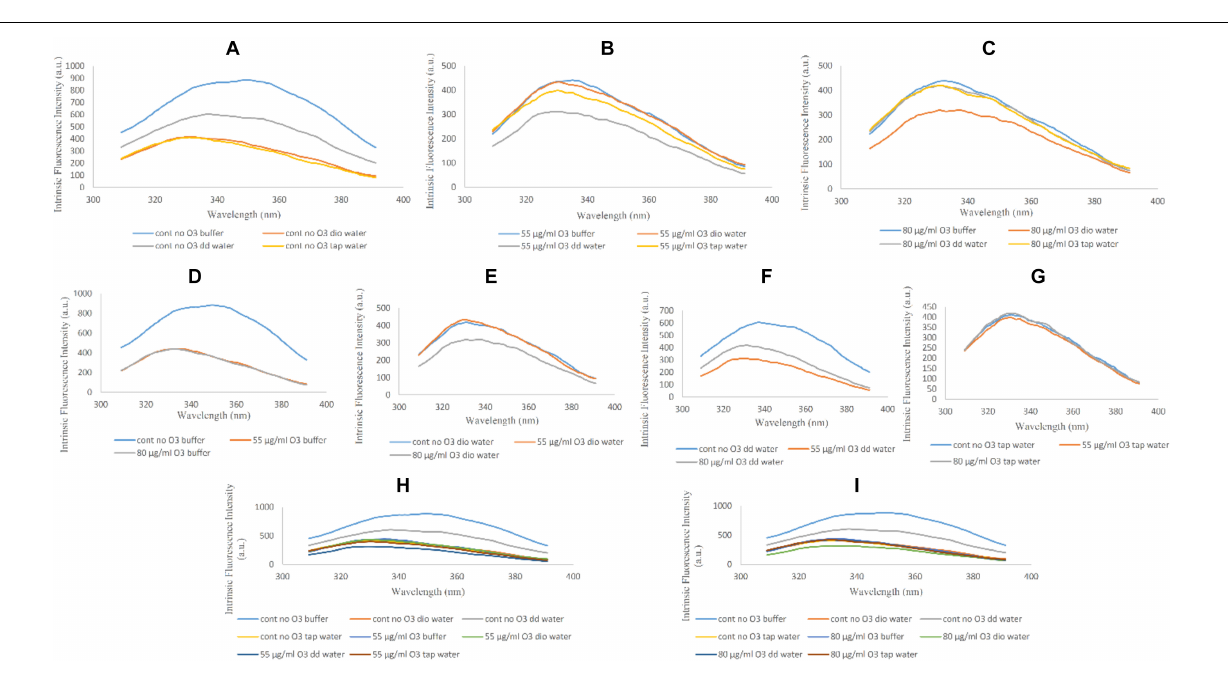
FIGURE 2 | Intrinsic fluorescence spectra of non-ozonated and ozonated Hb samples at concentrations of 55 and 80 µ g/ml in the presence of phosphate buffer and diluted versions with different water types. The fluorescence spectra were measured after excitation at 280 nm. (A) Non-ozonated Hb in phosphate buffer and different water types. (B) Hb ozonated with 55 µ g/ml ozone in phosphate buffer and different water types. (C) Hb ozonated with 80 µ g/ml ozone in phosphate buffer and different water types. (D) Non-ozonated and ozonated Hb with 55 and 80 µ g/ml ozone in phosphate buffer. (E) Non-ozonated and ozonated Hb with 55 and 80 µ g/ml ozone in phosphate buffer diluted with deionized (Dio) Water. (F) Non-ozonated and ozonated Hb with 55 and 80 µ g/ml ozone in phosphate buffer diluted with double distilled (DD) Water. (G) Non-ozonated and ozonated Hb with 55 and 80 µ g/ml ozone in phosphate buffer diluted with Tap Water. (H) Non-ozonated and ozonated Hb with 55 µ g/ml ozone in phosphate buffer and diluted in various different water types. (I) Non-ozonated and ozonated Hb with 80 µ g/ml ozone in phosphate buffer and diluted in various different water